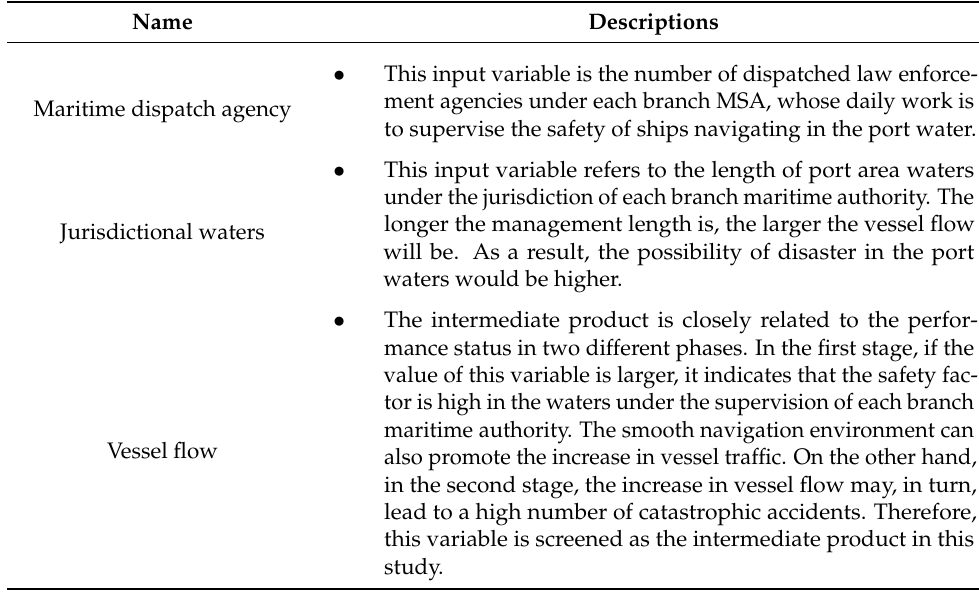
Table 2. Descriptions for selected variables in this